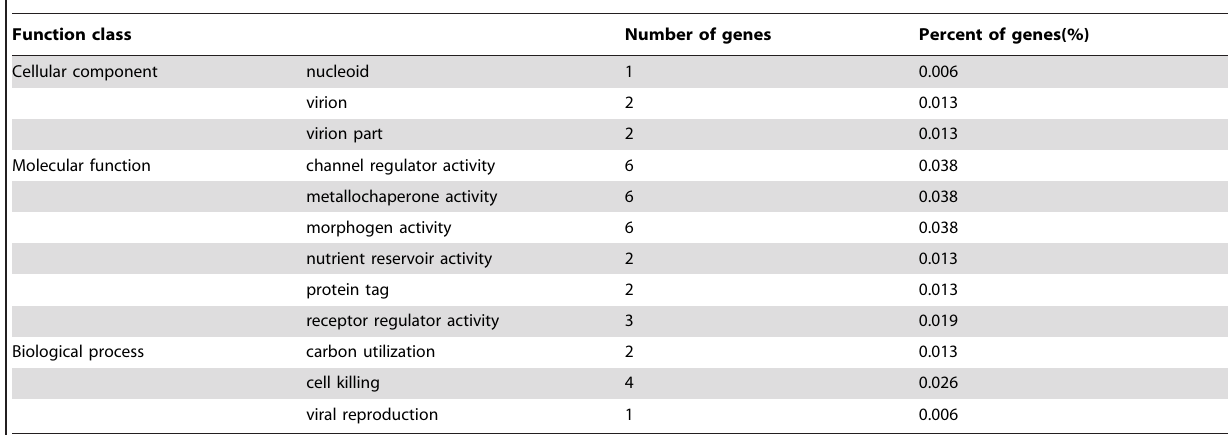
Table 5. GO categories contain few genes.